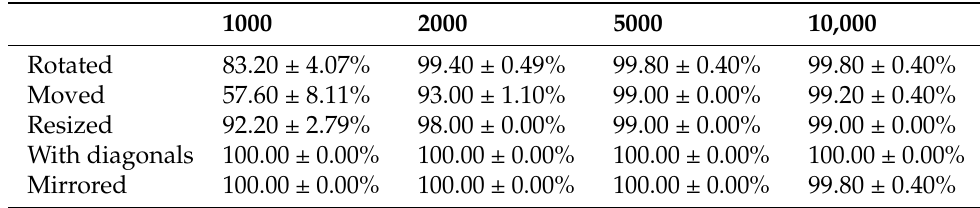
Table 8. The number of transformed objects: 10; Level of noise: